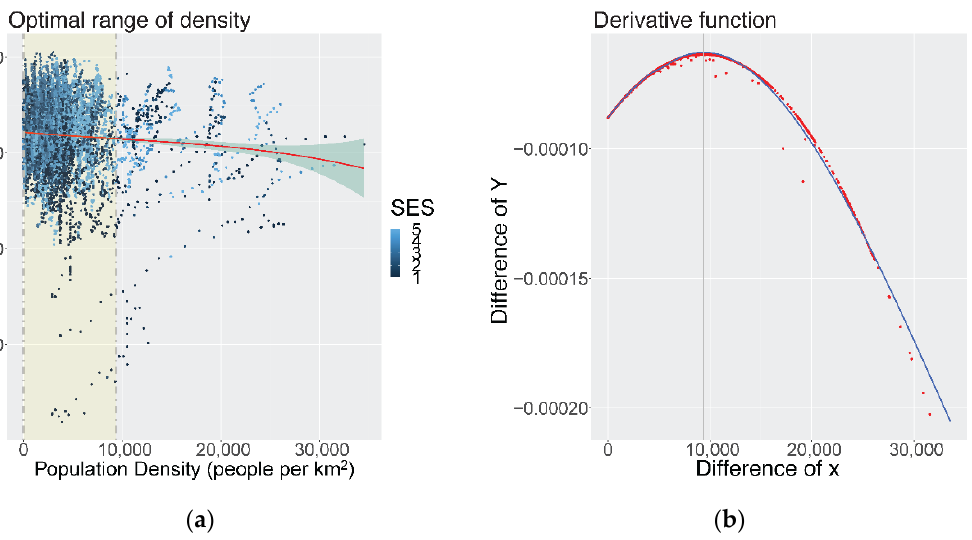
Figure 3. ( a ) Smoothed cubic spline with the shaded area representing the ‘optimal range’ identified of population density (people per km 2 ) and life expectancy at birth, Metro Vancouver, 1990–2016; ( b ) The first order derivative to identify the inflection point and threshold of densification.